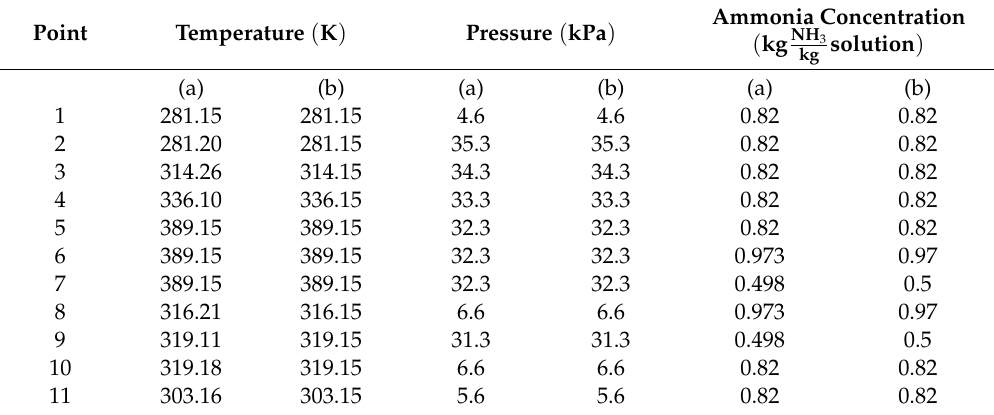
Table 5. Validation results of the power ammonia-water Kalina cycle operating conditions gained from present work (a) with reported data for the existing power plant in H ú sav í k [16] (b).